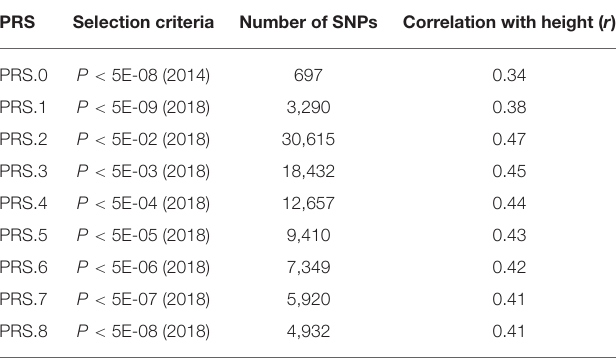
TABLE 2 | Characteristics of nine polygenic risk scores